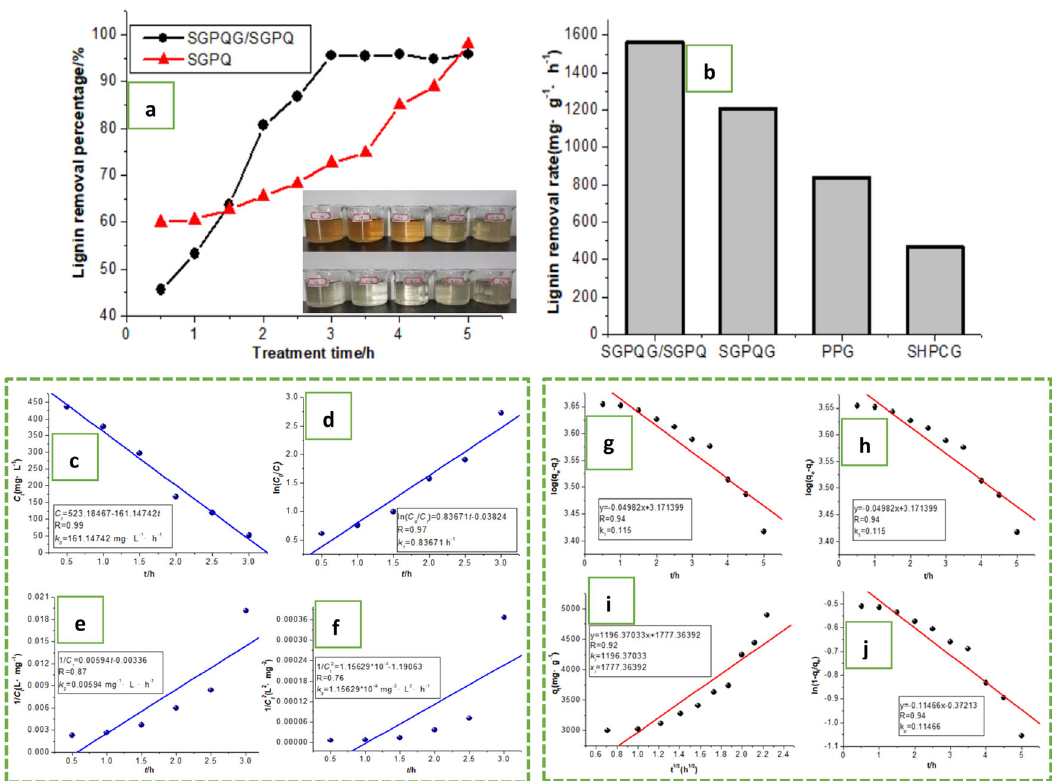
Fig. 3 Kinetics behaviors of SGPQG/SGPQ treatment with lignins. a The effect of different time on SGPQG/SGPQ and SGPQG treatment with lignin. b Comparing the lignin removal rates of SGPQG/SGPQ and SGPQG to PPG and SHPCG obtained in the pre-works. The results of the C t data of SGPQG/SGPQ treatment with lignins to fi t the serial reaction kinetics equations: c fi tting the zero-order reaction equation, d the fi rst- order reaction equation, e the second-order reaction equation, and f the third-order reaction equation. The results of the adsorption data of SGPQG skeleton components towards lignins to fi t the serial adsorption kinetics equations: g Fitting the pseudo- fi rst kinetics model, h the pseudo-second kinetics model, i the intraparticle diffusion model, and j the particle diffusion